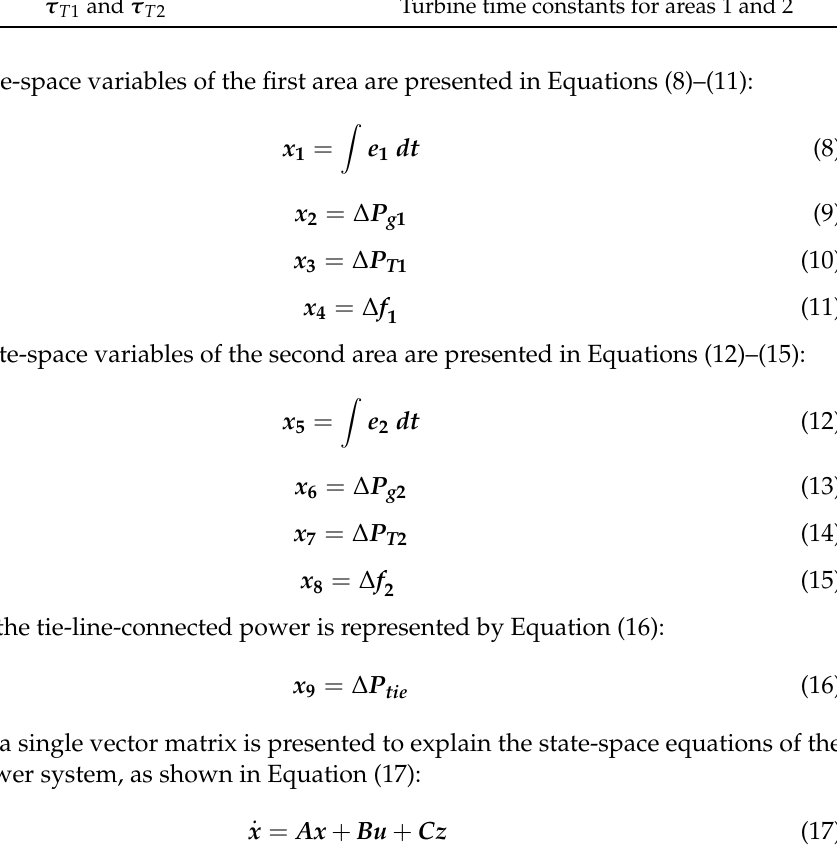
Table 1. Cont. Parameters Definition B 1 and B 2 Tie-line frequency bias in areas 1 and 2 τ g 1 and τ g 2 Time constants of governor for areas 1 and 2 τ T 1 and τ T 2 Turbine time constants for areas 1 and